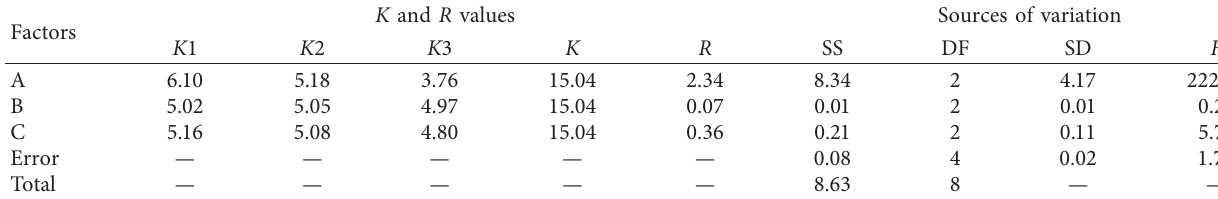
Table 7: Range and variance analyses of the flexural strength.